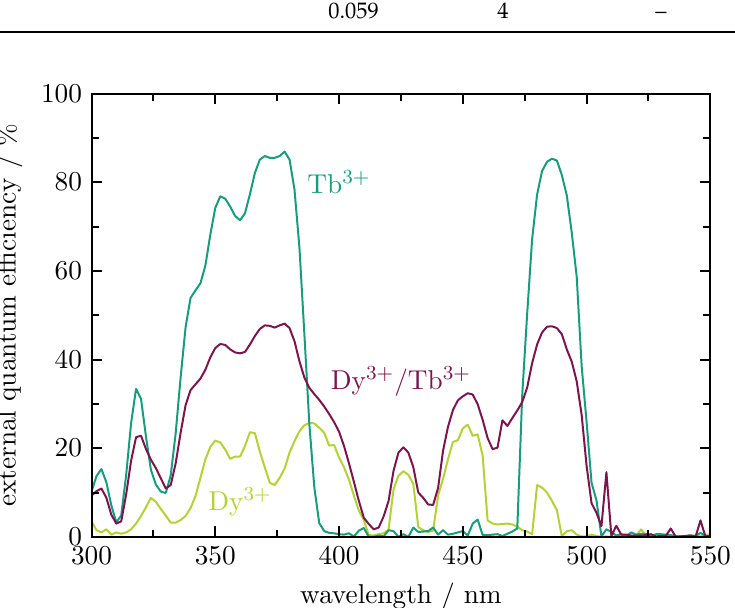
Figure 5. External quantum efficiencies of Dy 3 + (0.23at.%) and Tb 3 + (2.61at.%) single-doped as well as Dy 3 + /Tb 3 + (0.22at.%/2.61at.%) double-doped BaB glasses.